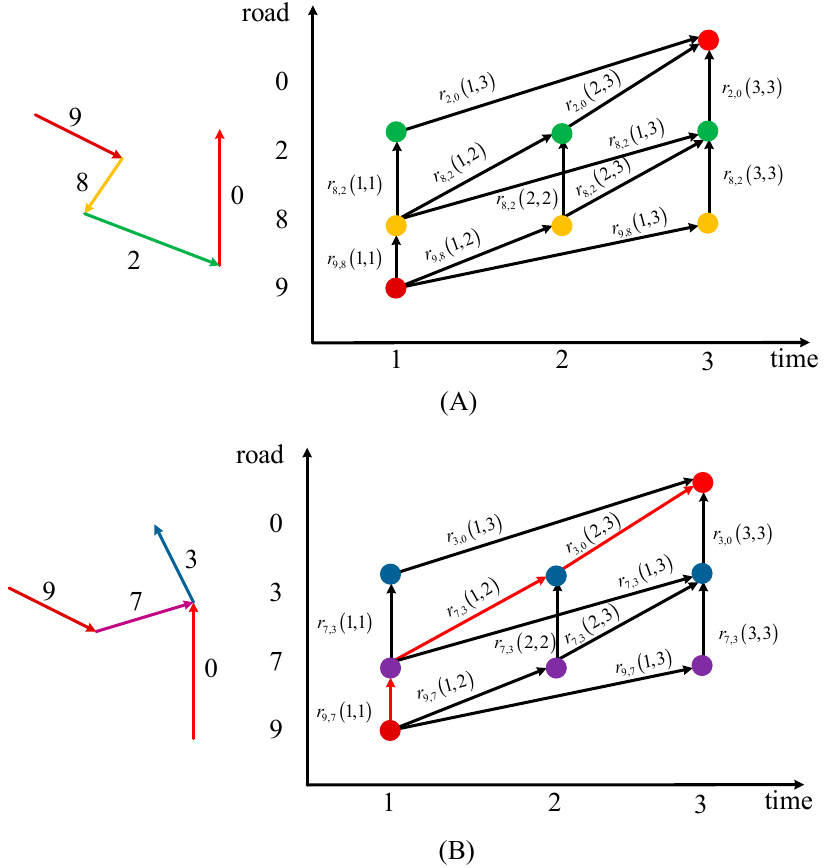
Figure 4. Two different transmission paths of road 9 to the TR (road 0) extracted from the road network.